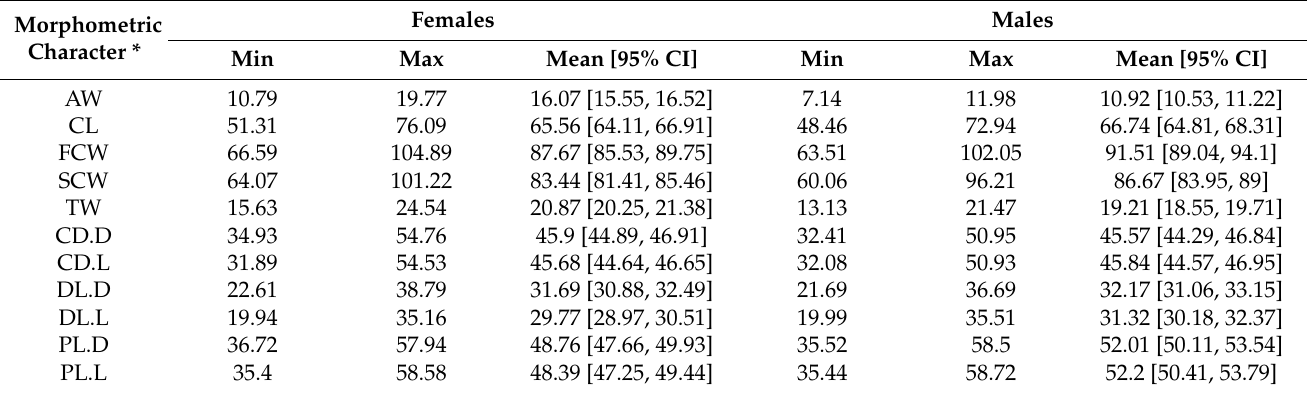
Table 2. Minimum (min), maximum (max) and mean values with lower and upper limits of 95% confidence intervals [95% CI] for morphometric characters (mm) of males (N = 28) and females (N = 64) of Calappa granulata from the central eastern Adriatic